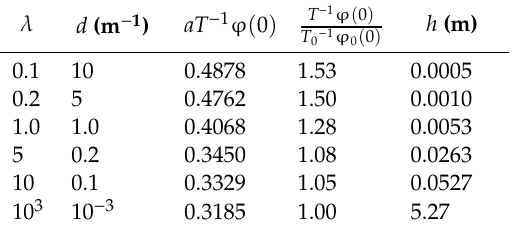
Table 3. Relative contact stresses aT − 1 ϕ ( 0 ) for a = 1 and different values of shear modulus parameter d . λ d (m − 1 ) aT − 1 ϕ ( 0 ) T − 1 ϕ ( 0 ) h (m) T 0 − 1 ϕ 0 ( 0 ) 0.1 10 0.4878 1.53